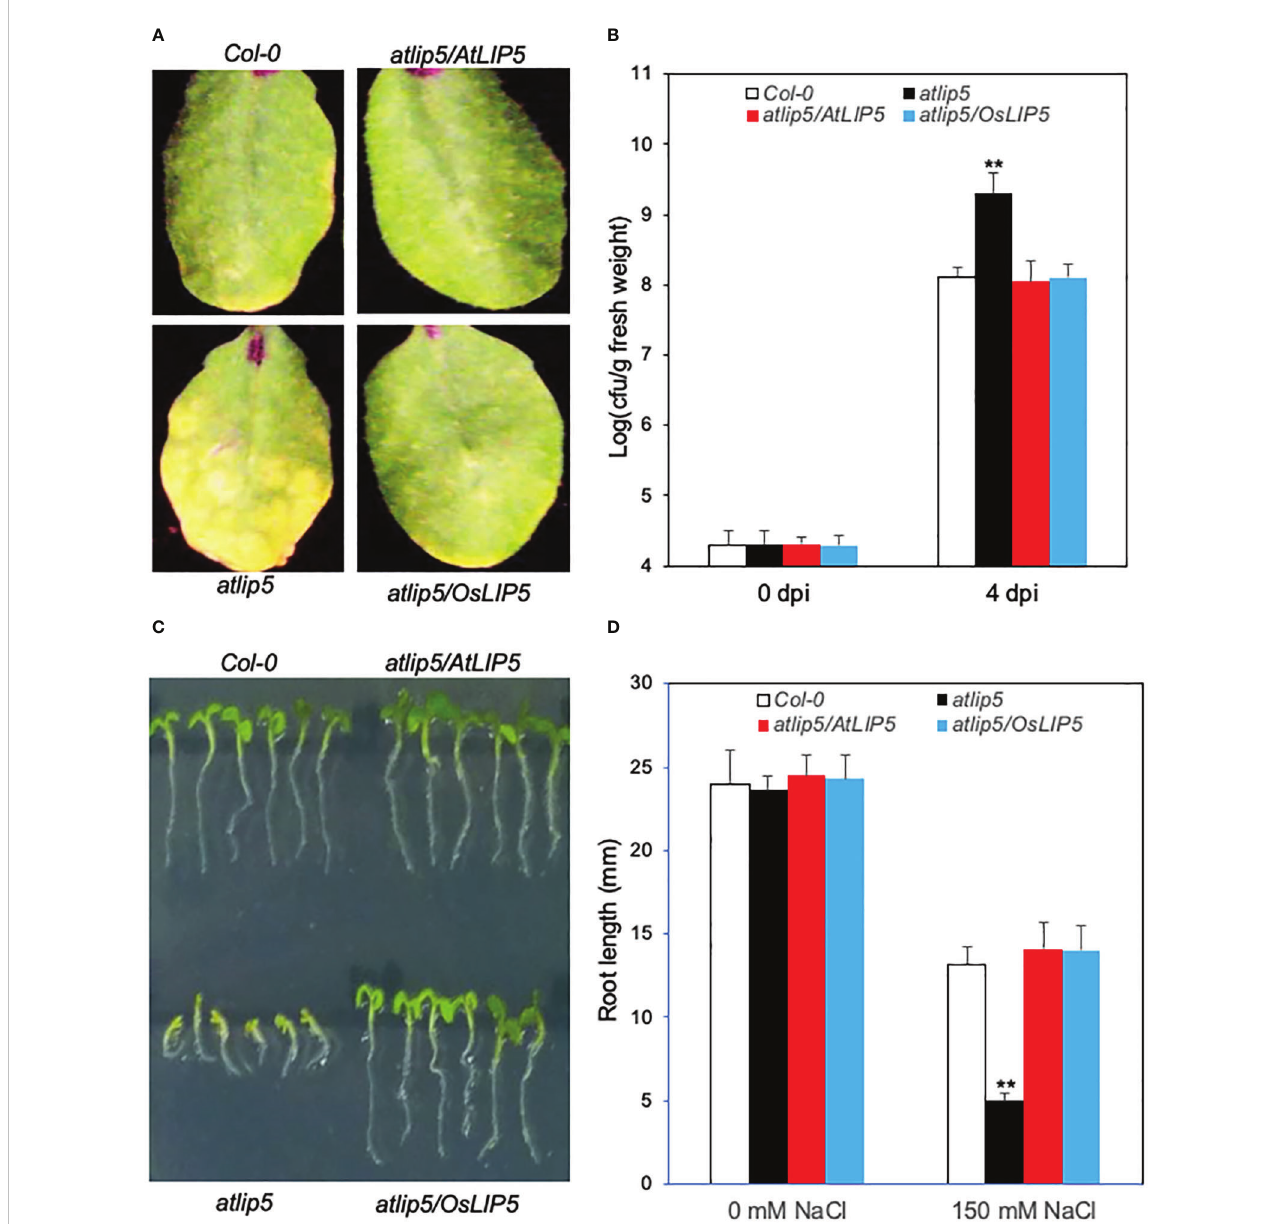
FIGURE 2 Complementation of Arabidopsis atlip5-1 mutant by rice OsLIP5 . Disease symptom development after infection by the virulent P. syringae pv tomato DC3000 ( Pst DC3000). Arabidopsis Col-0 WT, atlip5-1 and atlip5-1/AtLIP5 and atlip5-1/OsLIP5 lines with similar levels of LIP5-myc proteins were inoculated with Pst DC3000 (OD 600 = 0.0002 in 10 mM MgCl 2 ). Pictures of representative leaves were taken at 4 days post inoculation (dpi) (A) . Leaf samples were taken at 0 or 4 dpi to determine the bacterial growth (B) . The means and standard errors were calculated from 10 plants for each mutant. Double asterisks indicate statistically signi fi cant difference at P<0.01 in the colony forming units (cfu) per gram leaf fresh weight between Col-0 WT and atlip5 mutant lines determined at the same dpi. Arabidopsis seeds for the above genotypes were surface sterilized and sown on one-half-strength MS medium supplemented with 150mM NaCl. Photographs were taken 2 days post strati fi cation and 5 days post germination (C) . Root length of seedlings determined at 5 days post germination (D) . Means and standard errors were calculated from three experiments. Double asterisks indicate